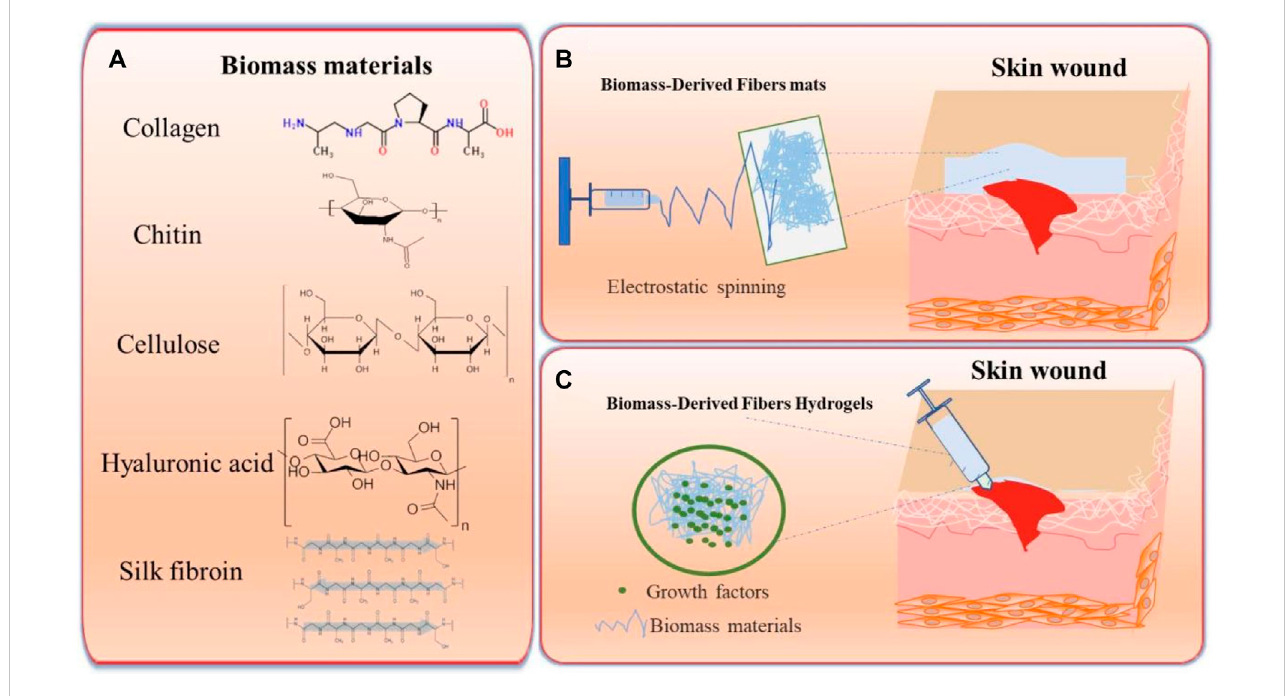
FIGURE 1 Schema of biomass-derived fi bers for skin-wound dressings. (A) Biomass material and their corresponding structural formulas. (B) Schema of Biomass- derived fi ber mats via electrostatic spinning used for the repair of skin wounds. (C) Schema of Biomass-derived fi ber hydrogels for the repair of skin wounds.